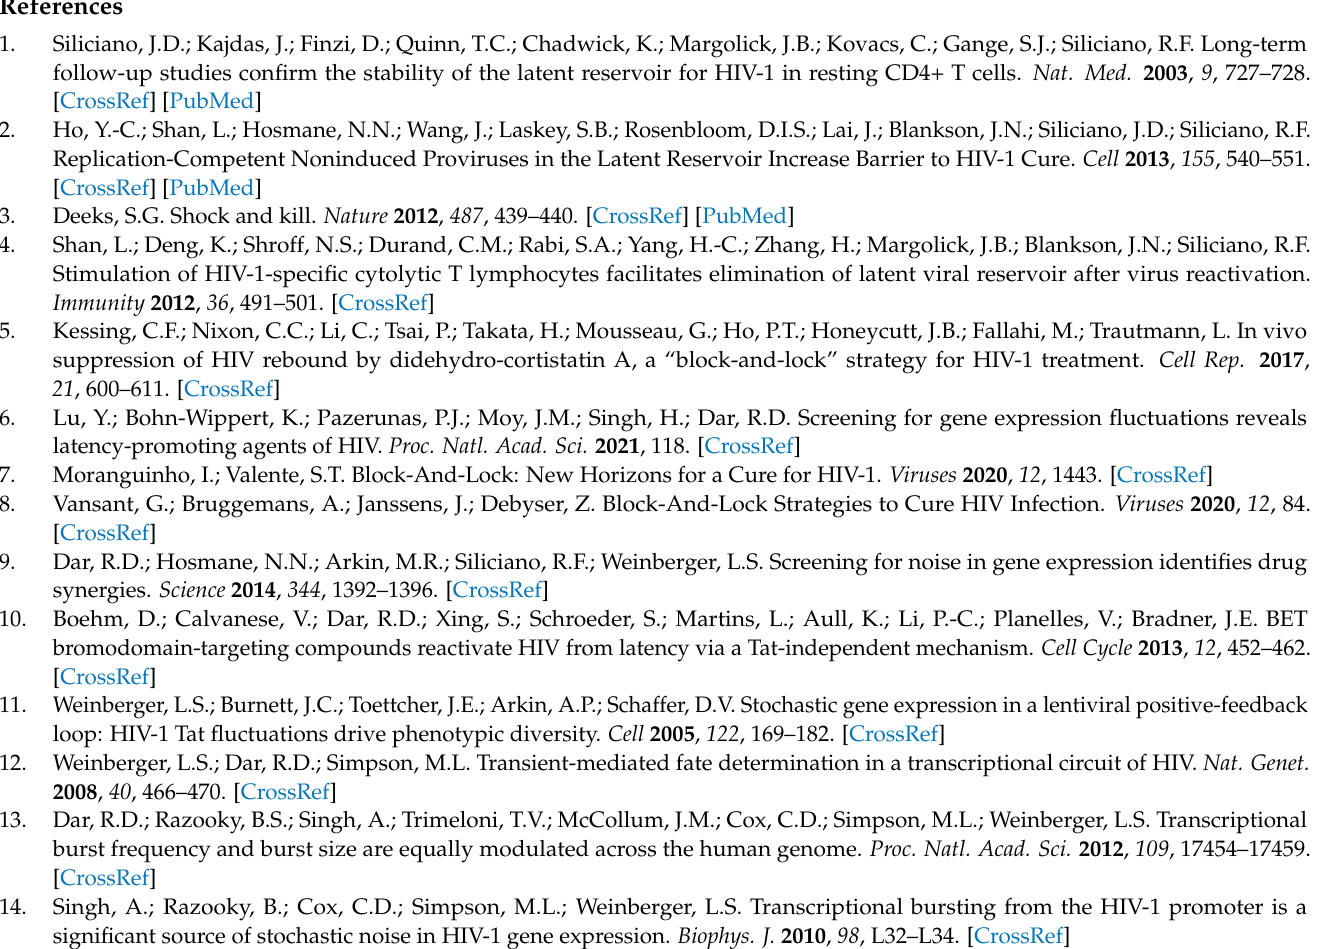
migration, Figure S7: LRA treatment and viral reactivation affect CXCR4 surface expression, Table S1: Simulation parameters for Figure 1C, Table S2: Burst size and frequency values used in Figure